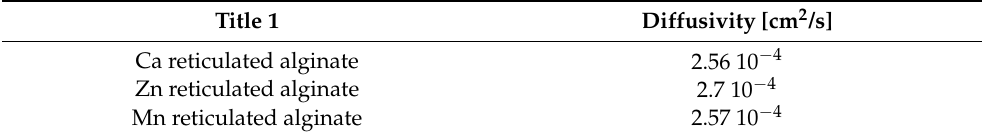
Table 1 resumes the results obtained. Table 1. Diffusion coefficient of RhB in alginate hydrogels reticulated with different